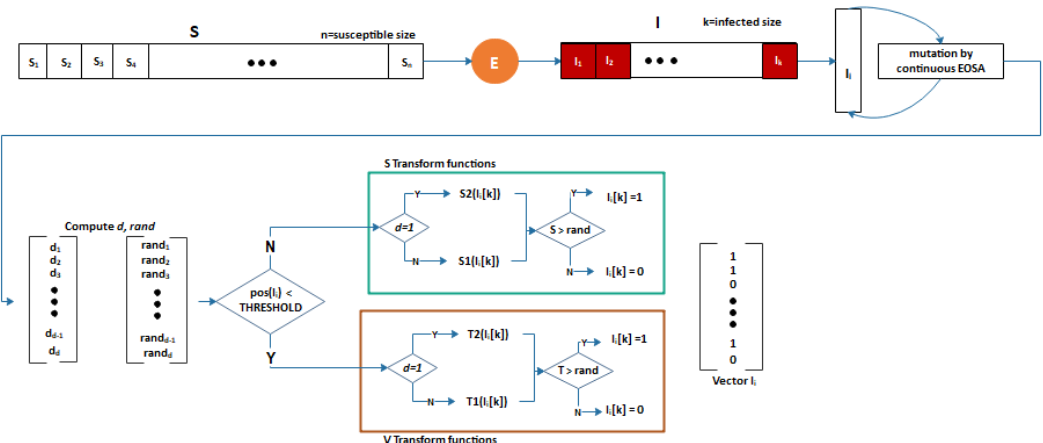
Figure 4. Process flow using BEOSA and BIEOSA to search for the best individual in a discrete search